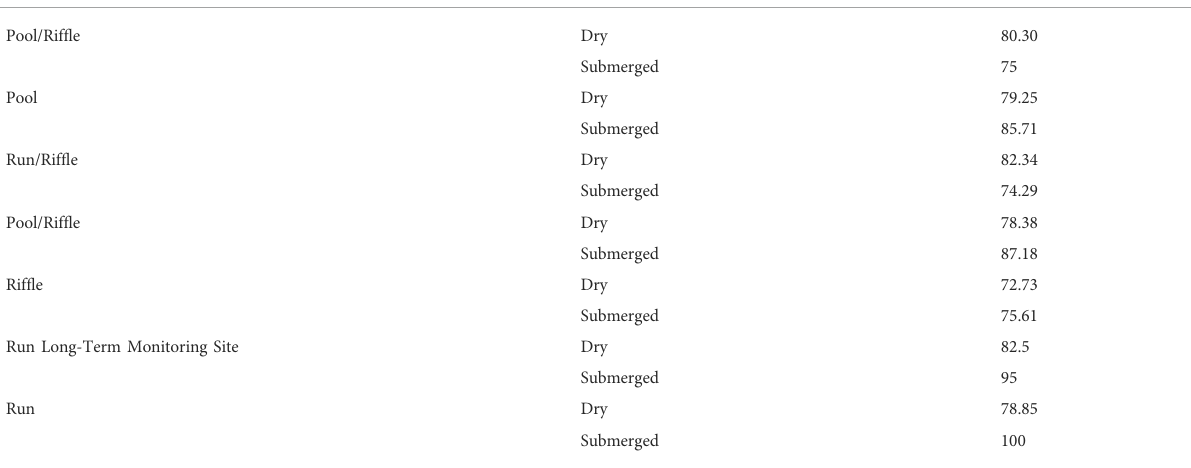
TABLE 3 Accuracy assessment conducted on the object-based imagine analysis of transects 1 – 7 for both dry and submerged substrate, which is the percent agreement between the training and predicted segments.